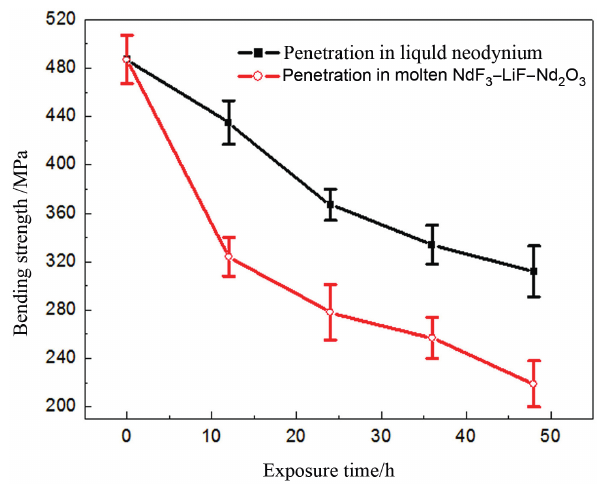
Figure 5: Bending strength as a function of exposure time for TiB 2 /TiC